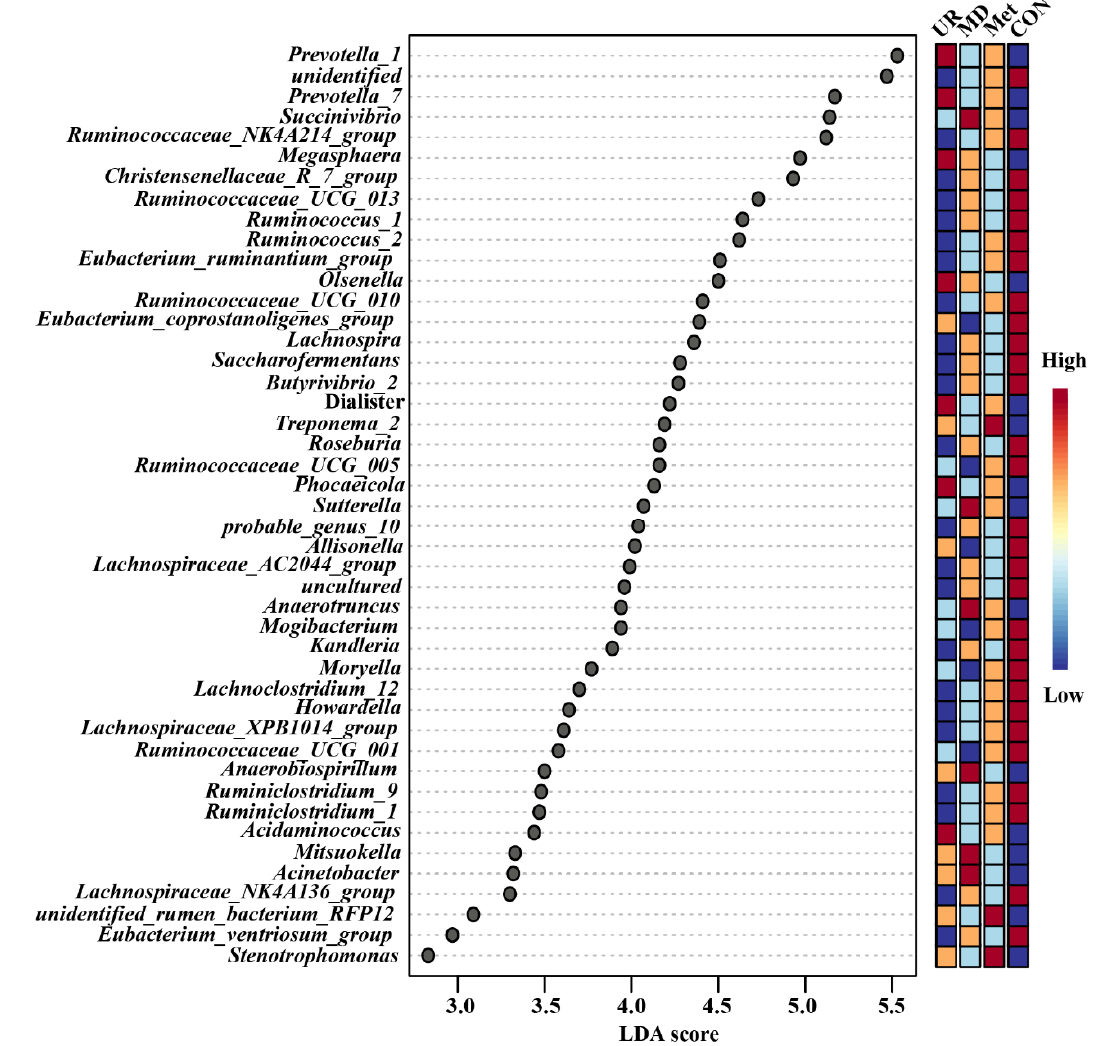
Figure 6. Linear discriminant analysis effect size approach identifying most differential genera in microbiota in response to urea, methionine, and methionine dipeptide supplementation. CON = no additive, UR = urea addition, Met = methionine addition, and MD = methionine dipeptide addition. A cut-off value ≥ 2 was used for the linear discriminant analysis (LDA) score. Only the top 45 significantly different genera are shown; n = 5 per treatment per time.